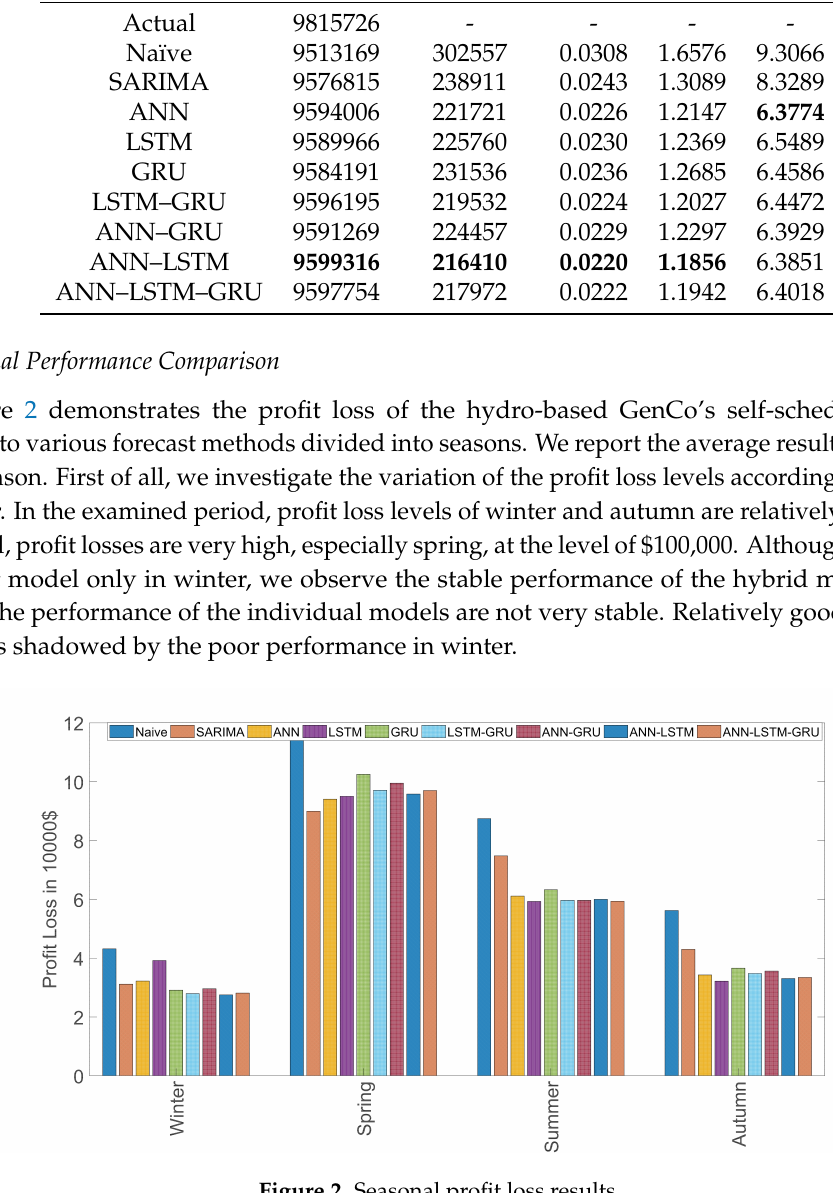
Figure 2. Seasonal profit loss